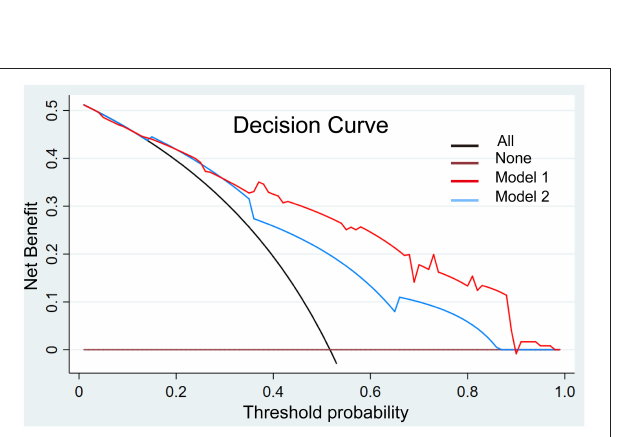
FIGURE 6 | Decision curve analysis with the comparison of the imaging models. The decision curve showed that if the threshold probability in the clinical decision is more than 18%, using the imaging nomogram to predict risk classification adds more benefit than either the treat-all-patients scheme or the treat-none scheme. Within this range, the net benefit was comparable based on two models with several overlaps, and the model with AA showed